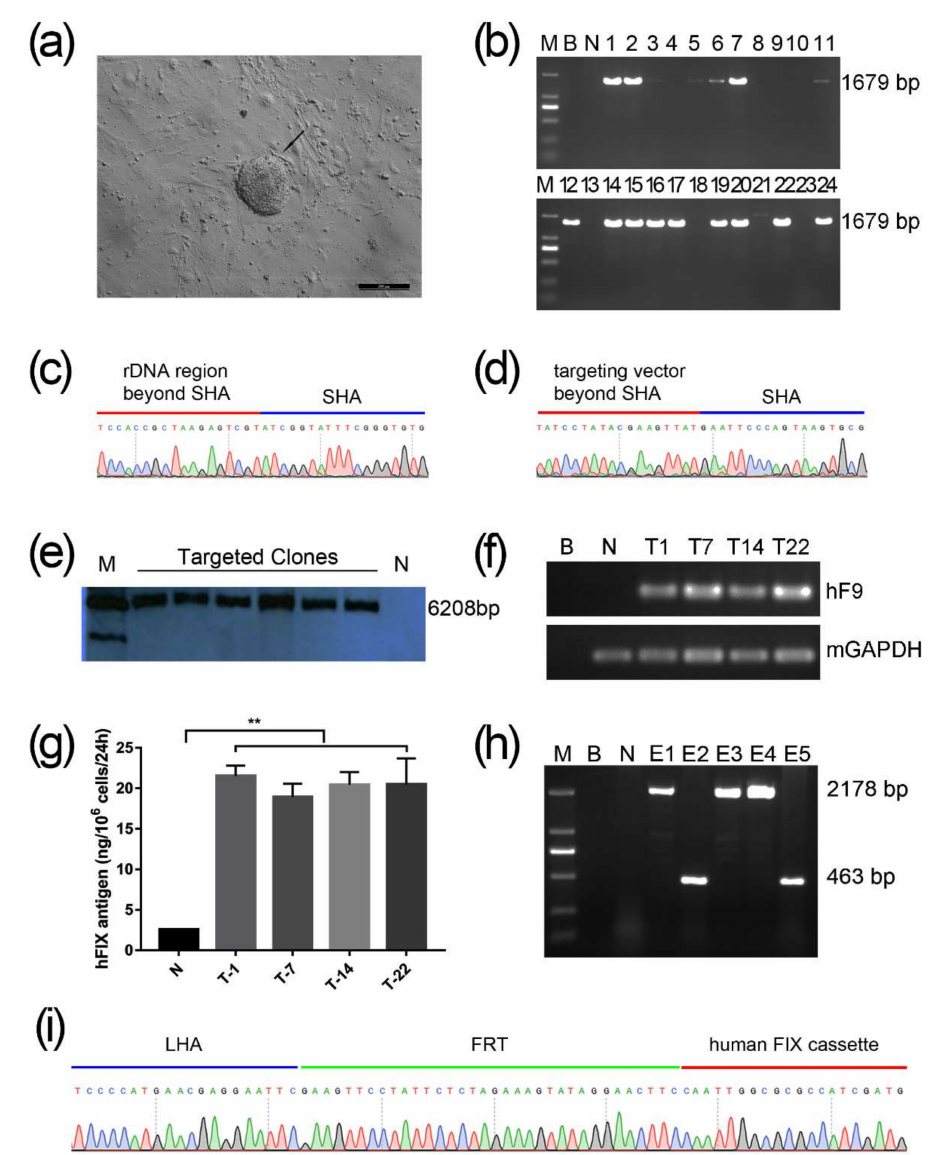
Figure 3. Identification of rDNA site-specific gene targeted mESCs. ( a ) The black arrow indicates a typical mESCs clone after nucleofection with sg1/6-Cas9n and pMrnF9 under selection by G418 for seven days. Scale bar: 200 µ m. ( b ) Twenty-four candidate targeted clones were picked and expanded, and followed by genomic DNA extraction. When amplified with primers F1 and R1, the site-specific integrated clones would obtain a 1679 bp band. M, DL2000 DNA Ladder. ( c , d ) The PCR products of F1/R1 were sequenced and the results revealed the site-specific integration. ( e ) Southern Blotting for six candidate targeted clones. Positive clones showed an expected band of 6208 bp. M, DNA Molecular Weight Marker II, DIG labeled. ( f ) mRNA of four targeted clones were detected by RT-PCR. ( g ) ELISA for hFIX antigen from the supernatant of targeted mESCs showed the higher level compared with untargeted mESCs (**, p < 0.01). ( h ) The Neo expression cassette which was flanked by a pair of synclastic FRT elements was removed by secondary nucleofection with the plasmid pCAG-Flpe. When amplified with the primer pair F2 and R2, the excised clones showed a band of 463 bp while 2178 bp indicated non-excision. M, DL2000 DNA ladder. ( i ) The PCR products of F2/R2 were sequenced and the results showed the excision of the Neo expression cassette. B, Blank, which represented the template was ddH 2 O; N, Negative control, which was